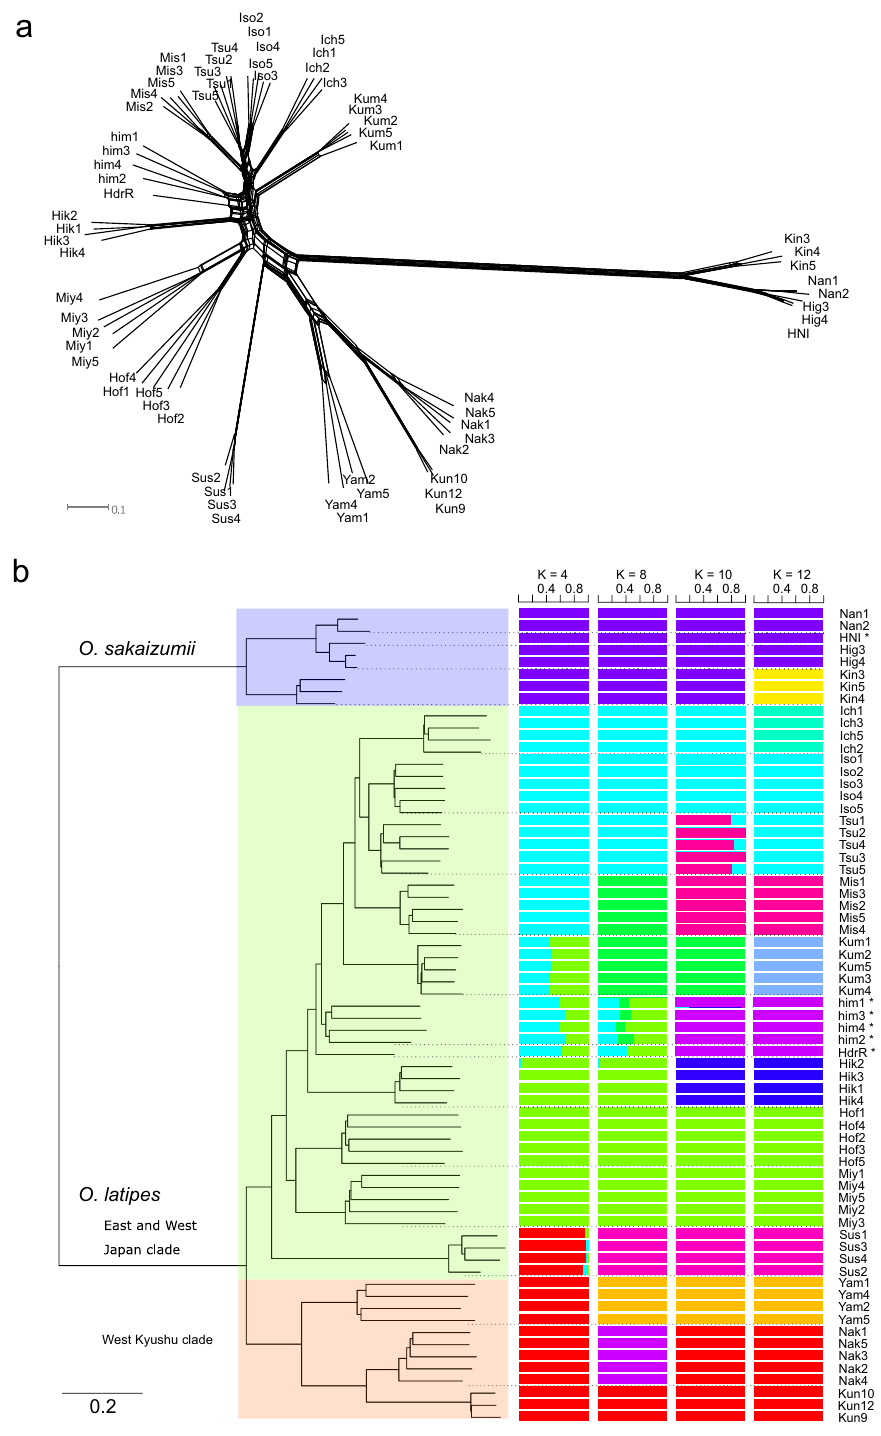
Figure 4. ( a ): Neighbor-net phylogenetic networks based on the 2987 SNPs; ( b ): Neighbor-joining tree and results of ADMIXTURE analysis for K = 4, 8, 10, 13. Asterisks indicate the artificial strains (Himedaka: him, HNI, HdrR). For the abbreviations of the wild populations, see Fig. 3 and Table